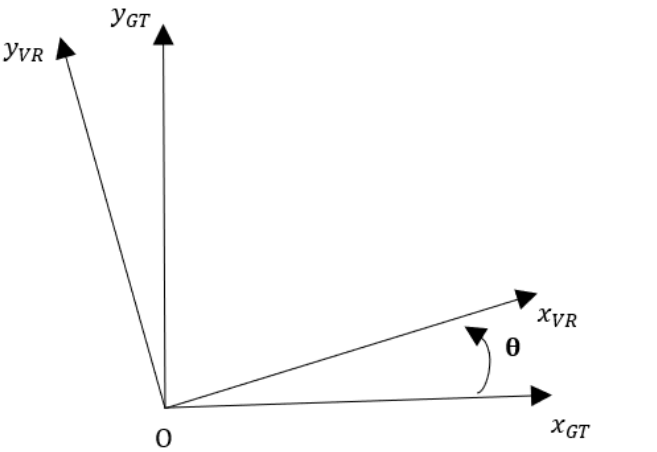
Figure 1. Fully immersive VR set up. ( A ) HTC Vive station base; ( B ) HTC Vive Sensor; ( C ) view of therapist; ( D ) view of participant; ( E ) participant’s feet from participant view.